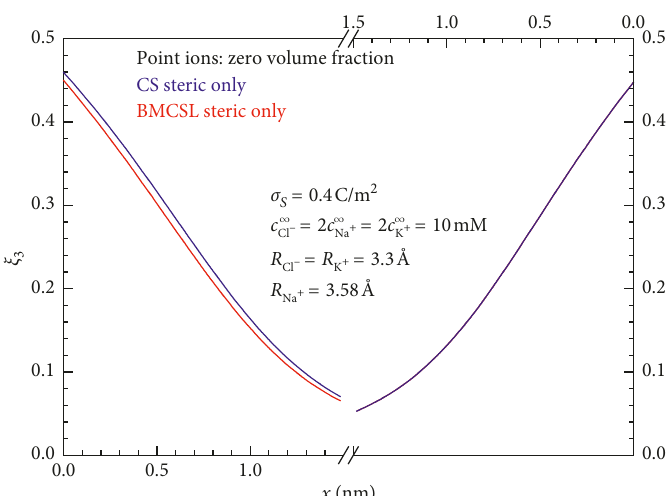
0.0 Figure 4: Total ionic volume fraction profiles in the diffuse electric double layers near negative (left) and positive (right) interfaces, calculated using the CS and BMCSL steric interaction only models and mixed aqueous NaCl and KCl solutions with the indicated